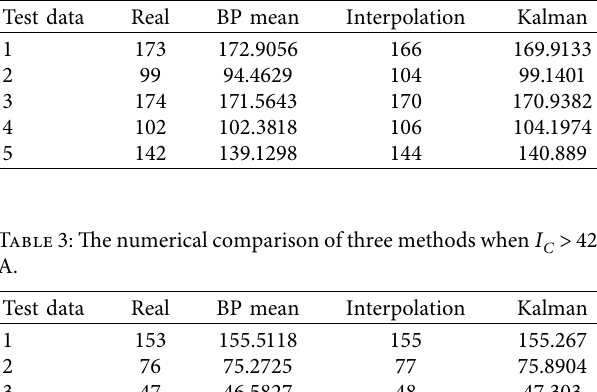
Figure 11: (a) The comparison of errors when I Table 2: The numerical comparison of three methods when I A. Test data